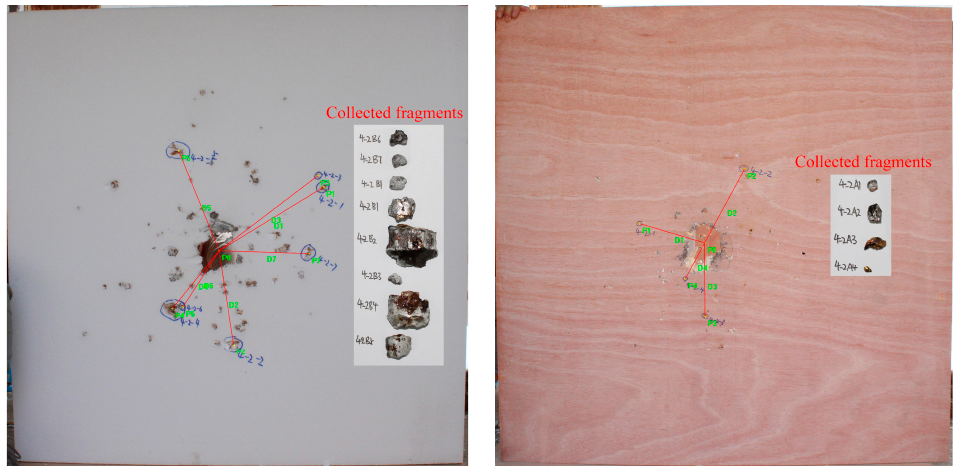
Figure 6. Radial scattering distance in the recovery plate and the corresponding collected frag- ments.